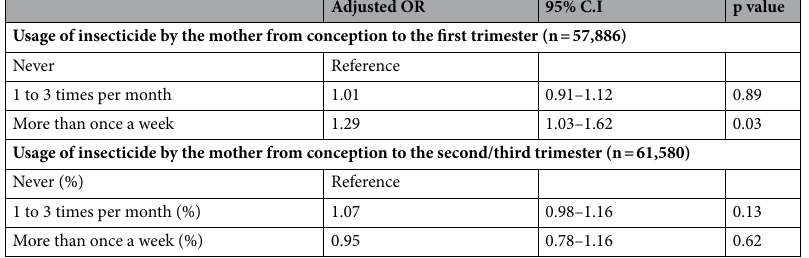
Table 3. Estimation by multiple imputation of the association between history of otitis media in the first year in children and maternal insecticide use from conception to the first (upper) and the second/third (lower) trimesters. OR odds ratio, 95% C.I. 95% confidence interval. These analyses were adjusted for sex, exclusive breastfeeding for the first 6 months, maternal age, gestational age, birth weight, living with siblings at 6 months, daycare attendance, maternal history of chronic otitis media, Hib vaccination, pneumococcal vaccination, maternal and paternal smoking history, exposure to secondhand smoke, diagnosis of trisomy 21, fertility treatment, family member’s smoking status, and maternal occupational